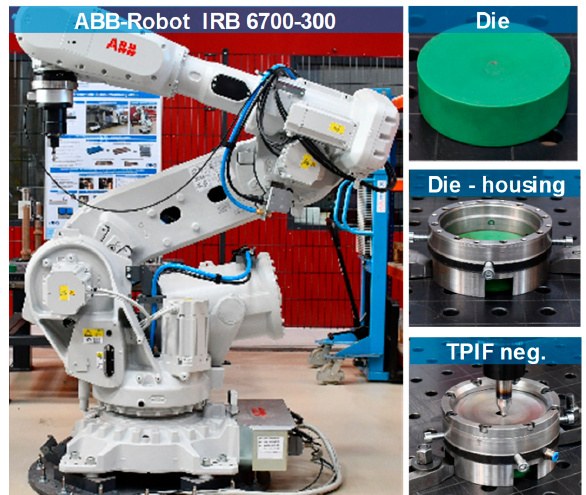
Figure 2. Experimental set-up of two-point incremental forming (TPIF) with a negative die using ABB- Robotic arm.